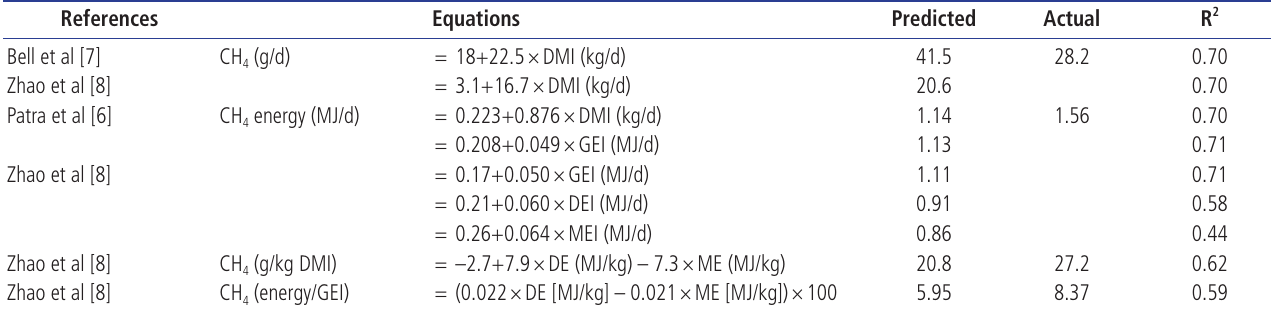
Table 4. Published equations used for validation of present